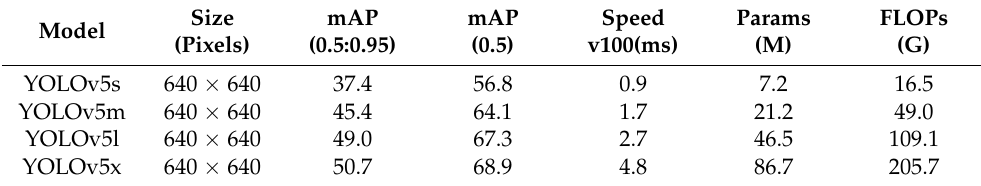
Table 1. Performance comparison of different versions of YOLOv5.